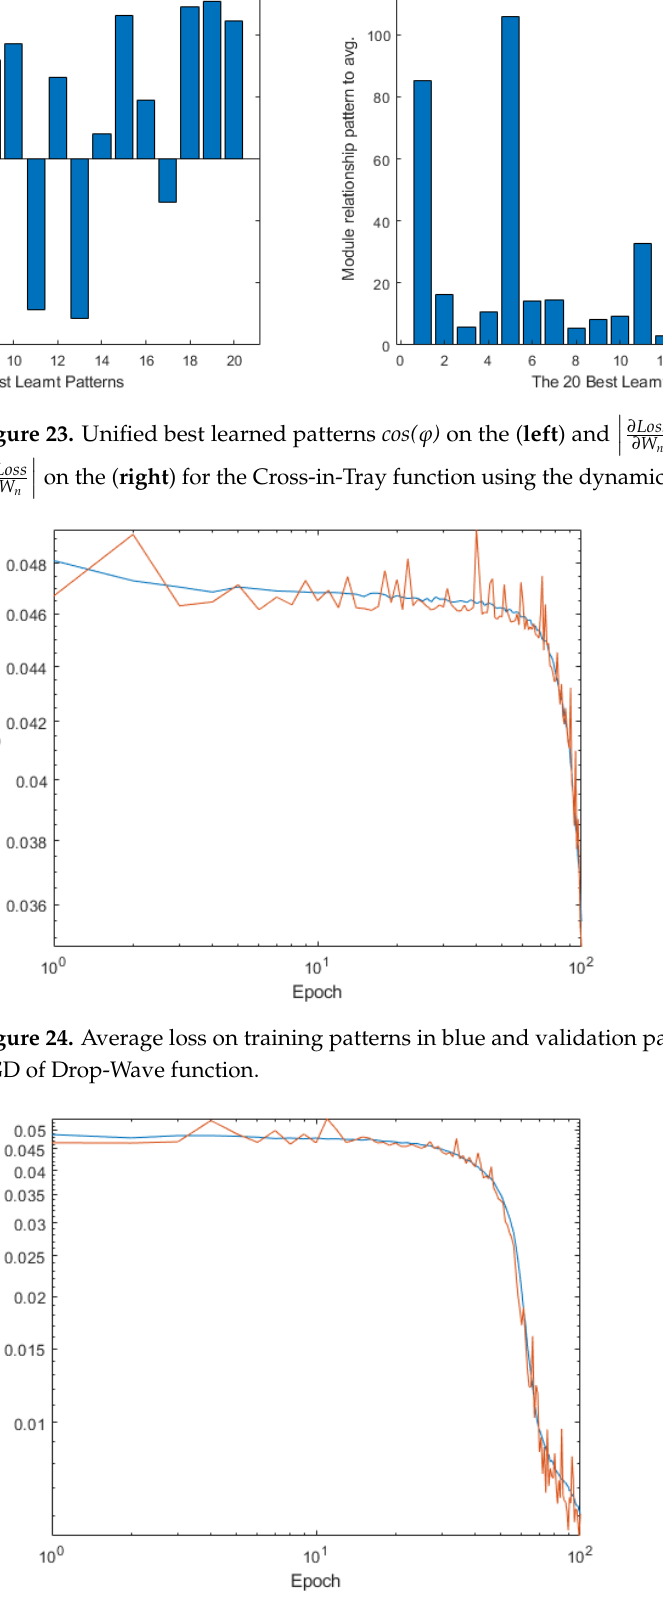
Figure 25. Average loss on training patterns in blue and validation patterns in orange for Dynamic alpha and Dynamic drop-out mixed together SGD of Drop-Wave function. alpha and Dynamic drop-out mixed together SGD of Drop-Wave